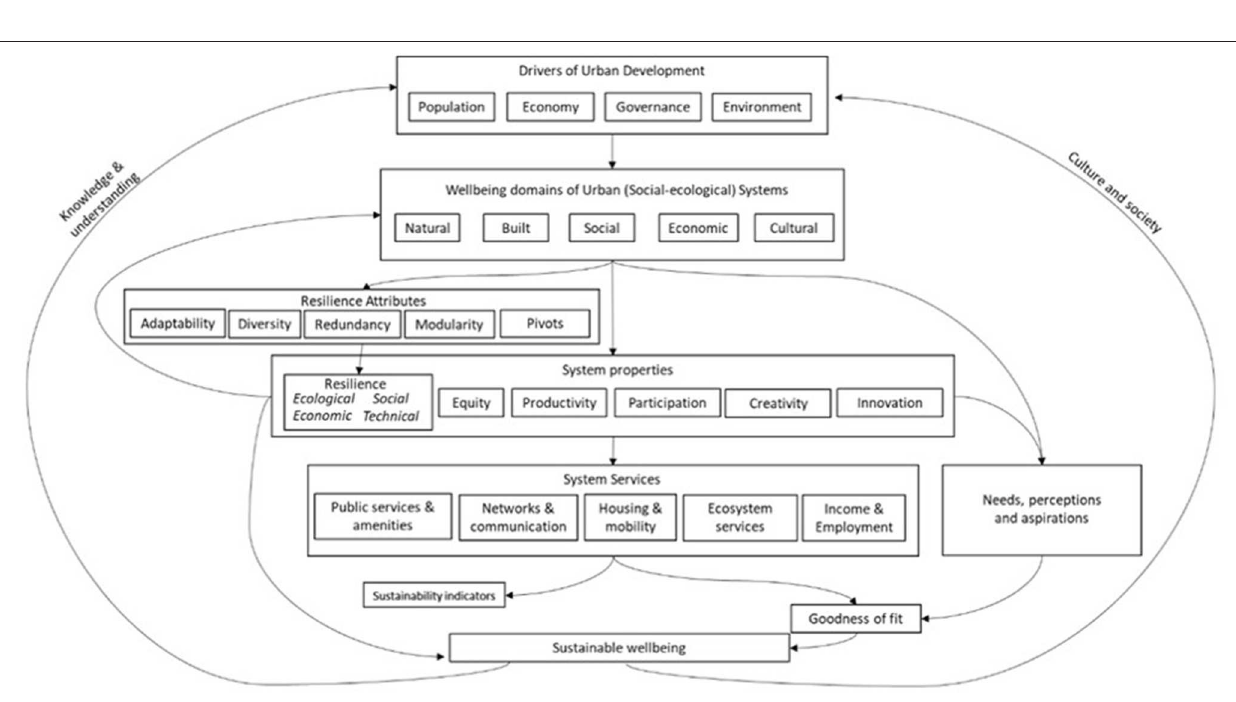
Frontiers in Sustainable Cities |